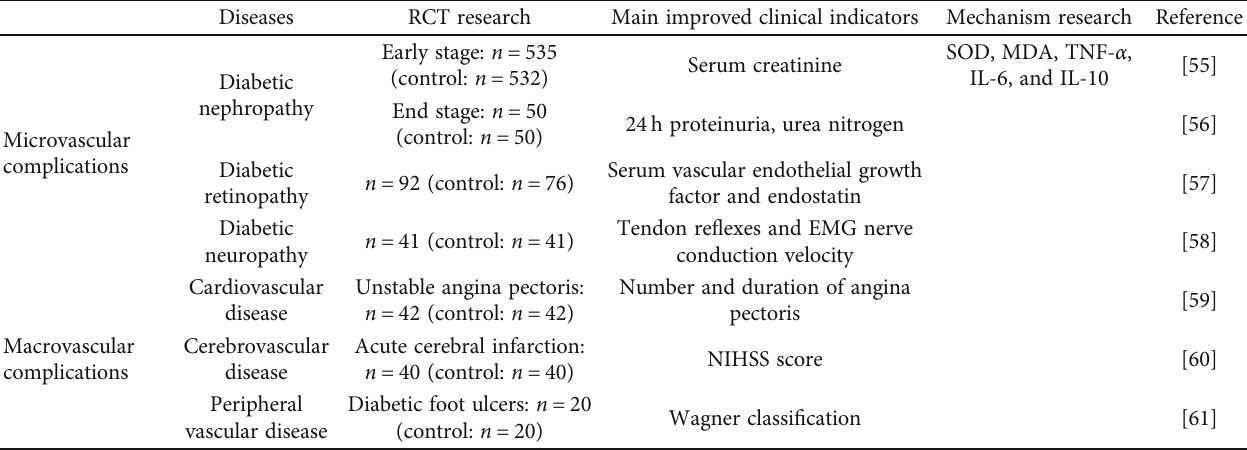
Table 2: The RCT research of SYI (90% HSYA) in the treatment of diabetes and diabetes complications.